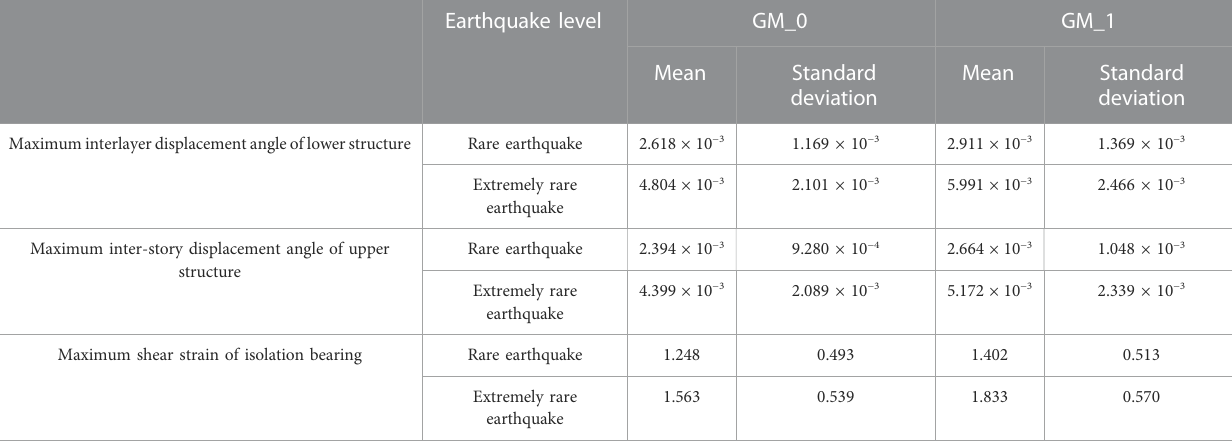
TABLE 5 Probabilistic characteristic parameters of structural response values of the isolation layer set in the fi rst story.